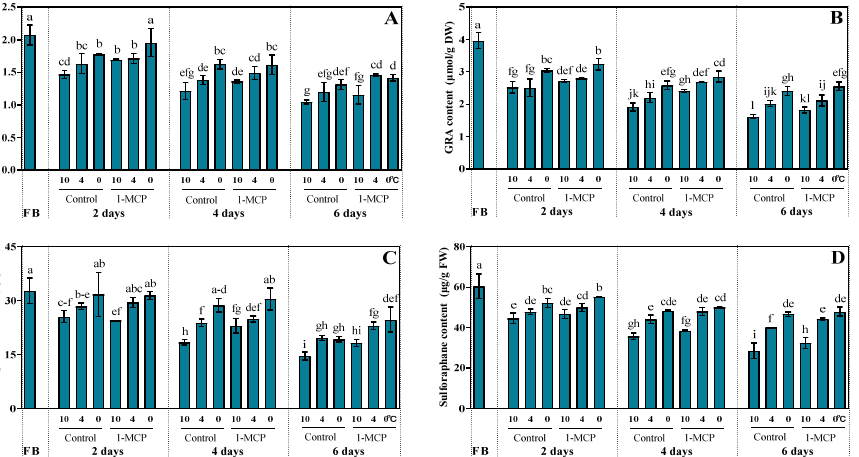
Figure 3. Effects of storage temperature on glucoraphanin and sulforaphane content in broccoli florets. Glucoraphanin content (( A ): Yanxiu, ( B ): Xianglv No.3), sulforaphane content (( C ): Yanxiu, ( D ): Xianglv No.3). Storage temperature: 10, 4, and 0 °C; control: without 1-MCP treatment; 1-MCP: 1-MCP treatment; FB: fresh broccoli florets; storage time: 2, 4, and 6 days. Error bars represent SD from three replications of under every treatment under storage experiment. Different letters indicate statistically significant differences among treatments ( p < 0.05).